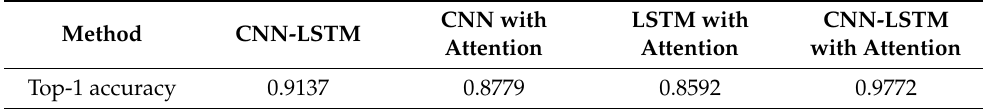
Table 3. Performance comparison of deep